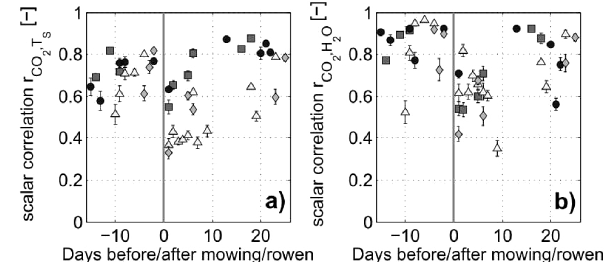
Figure 2. Daytime b(H) before (a) and after cutting events (b) . Data from rowen in 2009, mowing and rowen in 2010, and mow- ing in 2011; the median (solid line) and the 25 and 75% quantile (dashed line) of 16 days before and of 27 days after management are illustrated. H = 1.0; (proxy) scalar: CO 2 .